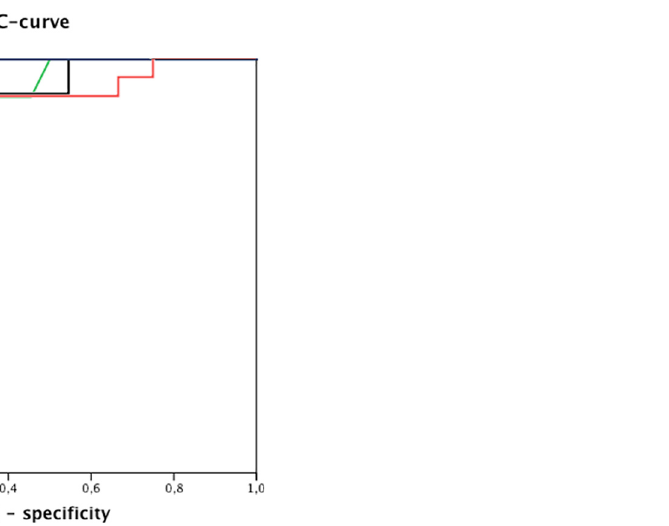
Fig 2. Receiver operating characteristic curve analysis with T-wave integral of the key channel 60 (blue lines; AUC 0.89), T-wave amplitude range of the key channel 90 (red lines; AUC 0.83), T peak -T end - interval in standard chest lead V 1 (black lines; AUC 0.8) and QTc time from standard ECG (green line; AUC 0.86).